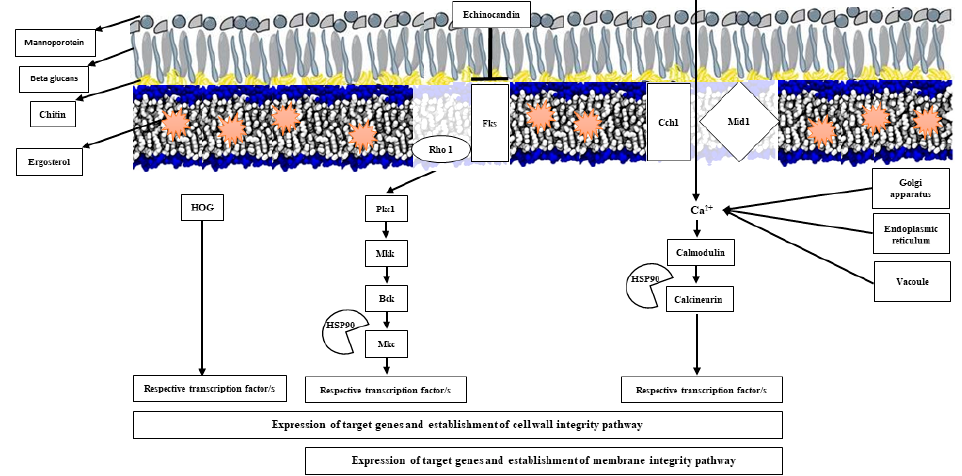
Figure 2. Mechanisms of antifungal tolerance. The mechanisms include rapid coordination of numerous signal transduction pathways that depend on the antifungal drug used. Echinocandin tolerance mechanism, known as the cell wall integrity pathway, involves protein kinase C (PKC), high ‐ osmolarity glycerol (HOG), and calcineurin pathways, followed by the overexpression of chitin synthase, and FKS1 and FKS2 to compensate for the reduction of β‐ 1,3 ‐ D ‐ glucan level in the cell wall. Membrane integrity pathway orchestrates the azole tolerance pathways, which includes PKC and calcineurin pathways. As it is shown, HSP90 plays a critical role in antifungal tolerance by stabilizing the key regulatory proteins.